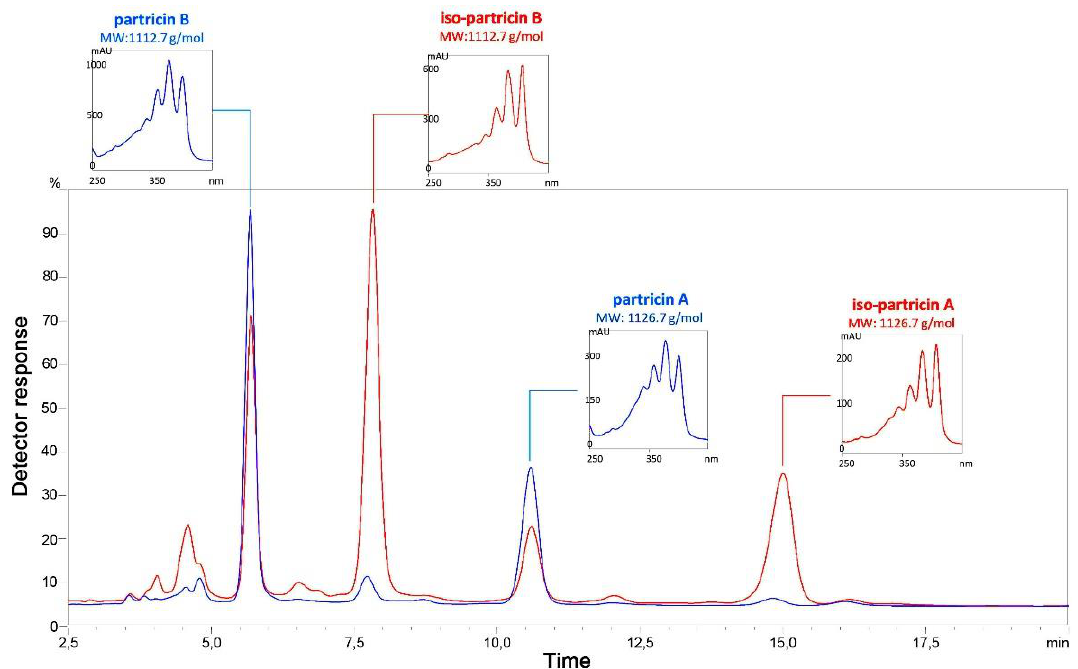
Figure 2. Superimposed HPLC–DAD–ESIMS chromatograms of partricin complex. Red line: sample dissolved and stored at room temperature for 24 h, with an unlimited access to daylight. Blue line: sample dissolved and stored at room temperature in darkness for 24 h (control).